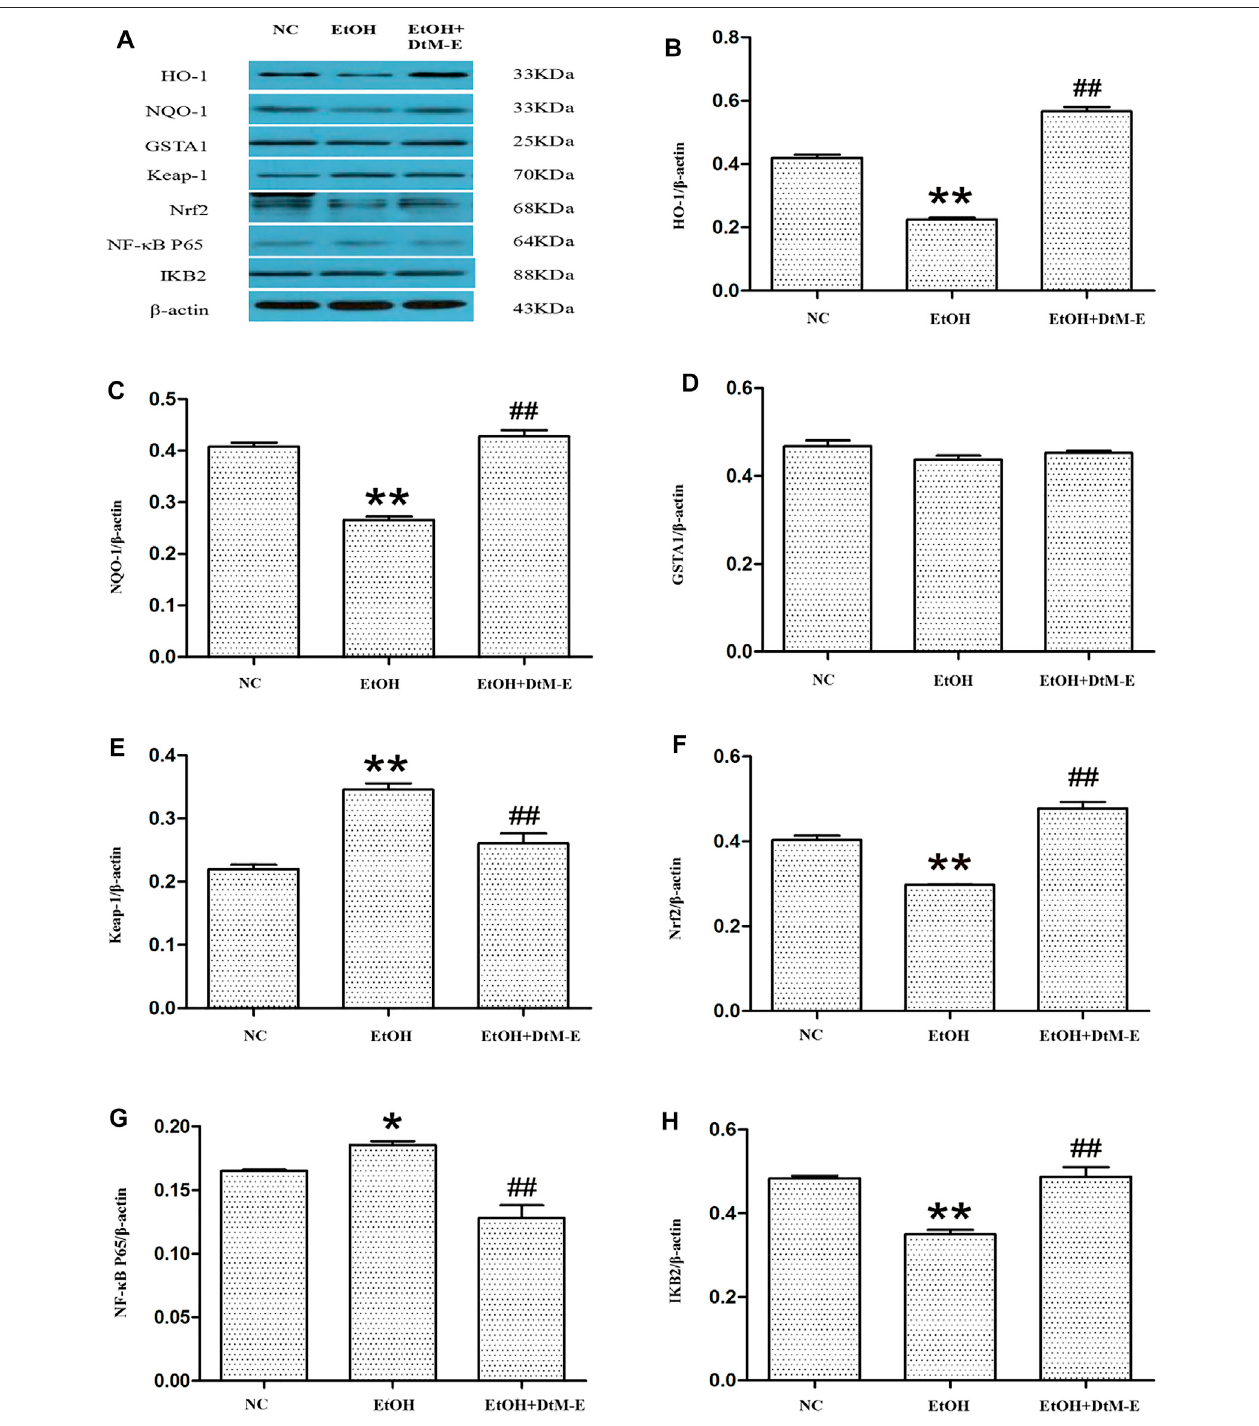
FIGURE 5 | The Western blot of Nrf2 and NF- κ B signaling (A) . Quanti fi cation of HO-1 (B) , NQO-1 (C) , GSTA1 (D) , Keap-1 (E) , Nrf2 (F) , NF- κ B P65 (G) , and IKB2 (H) expression. All data are presented as mean ± SD ( n = 6). ** p < 0.01, * p < 0.05 ( vs . control group); ## p < 0.01 ( vs . model group).